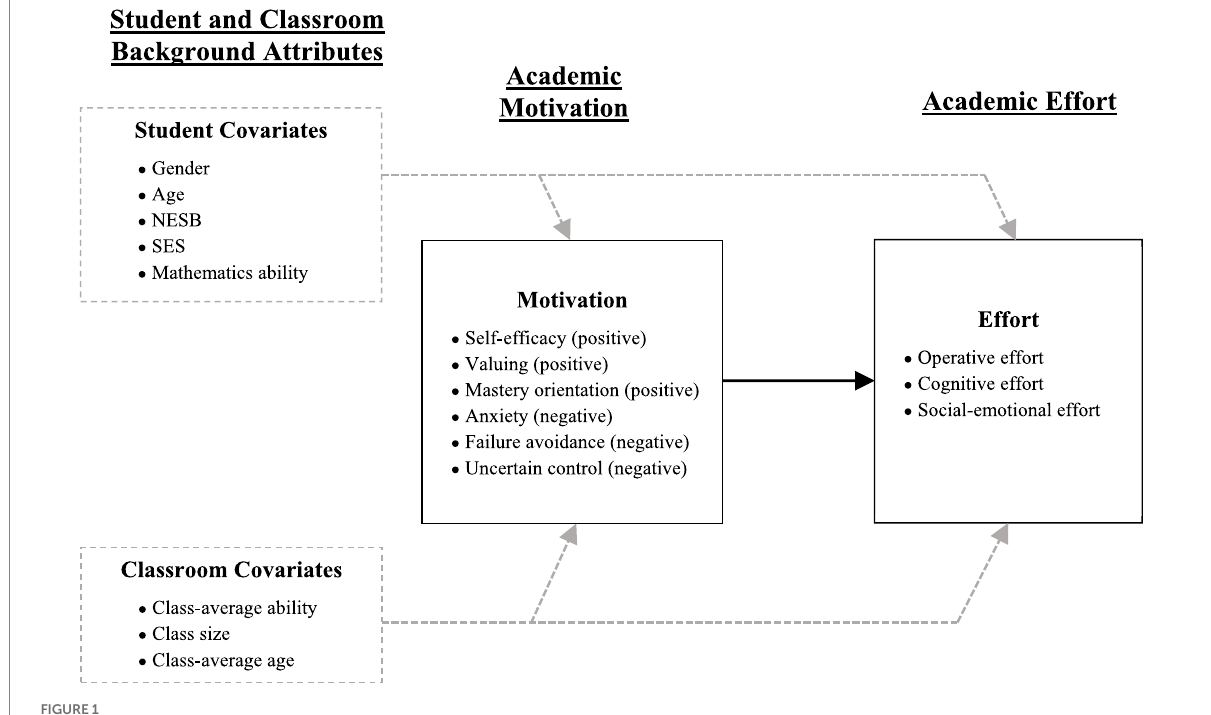
FIGURE 1 Hypothesized full process model (processes are estimated at student- and classroom-levels). SES, Social-economic status indicator; NESB, Non- English speaking background